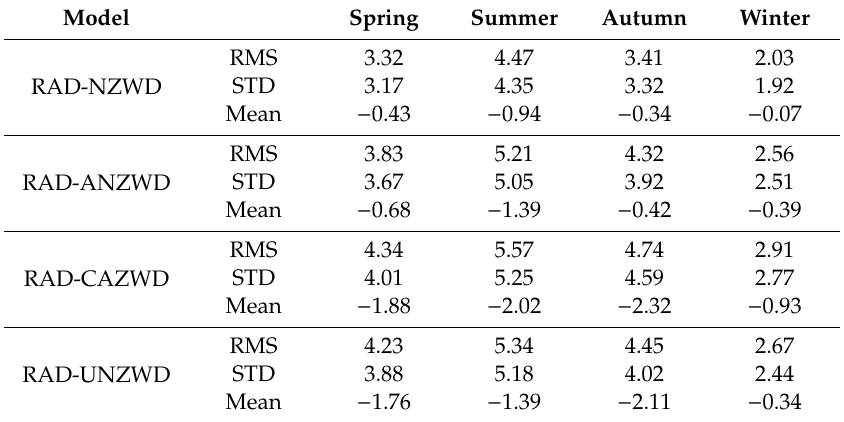
Table 3. Seasonal statistics of deviations between RAD and model-derived ZWD (Unit: cm). Model Spring Summer Autumn Winter RMS 3.32 4.47 STD 1.92 RAD-NZWD Mean − 0.43 − 0.94 RAD-ANZWD